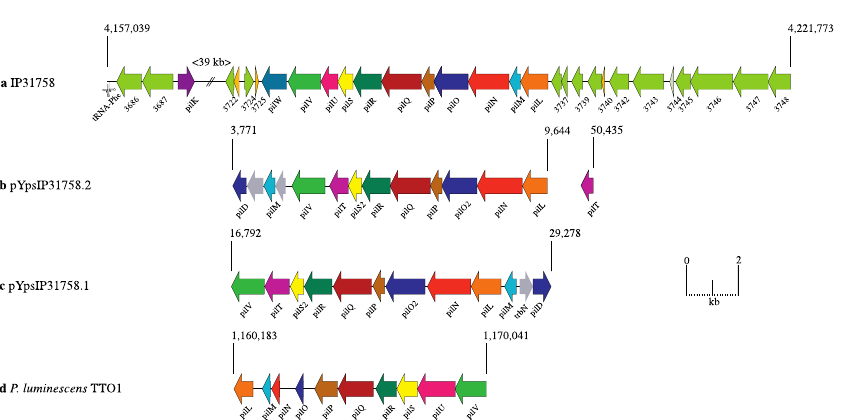
Figure 5. Genomic Architecture and Comparison of the Chromosomal and Plasmid-Borne Type IV pil Gene Clusters of Y. pseudotuberculosis IP31758 Y. pseudotuberculosis IP31758 harbors three pil (pilin) loci encoded by YAPI IP31758 on the core chromosome (A) and on both plasmids pYpsIP31758.2 (B) and pYpsIP31758.1 (C). The chromosomal pilWVUSRQPONML locus found within the YAPI IP31758 is more similar to that found on the chromosome of P. luminescens TTO1 (D). Corresponding pil genes are colored accordingly. Y. pseudotuberculosis IP31758 strain-specific YAPI CDSs are colored orange. Olive CDSs are shared by YAPI IP31758 and YAPI IP32777 .